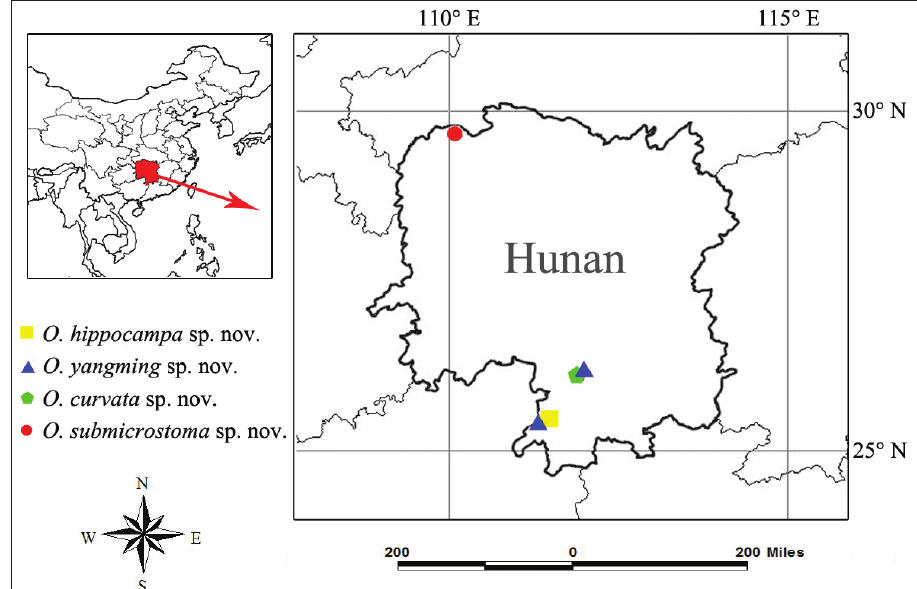
Figure 13. Distribution of new species the genus Otacilia from Hunan,